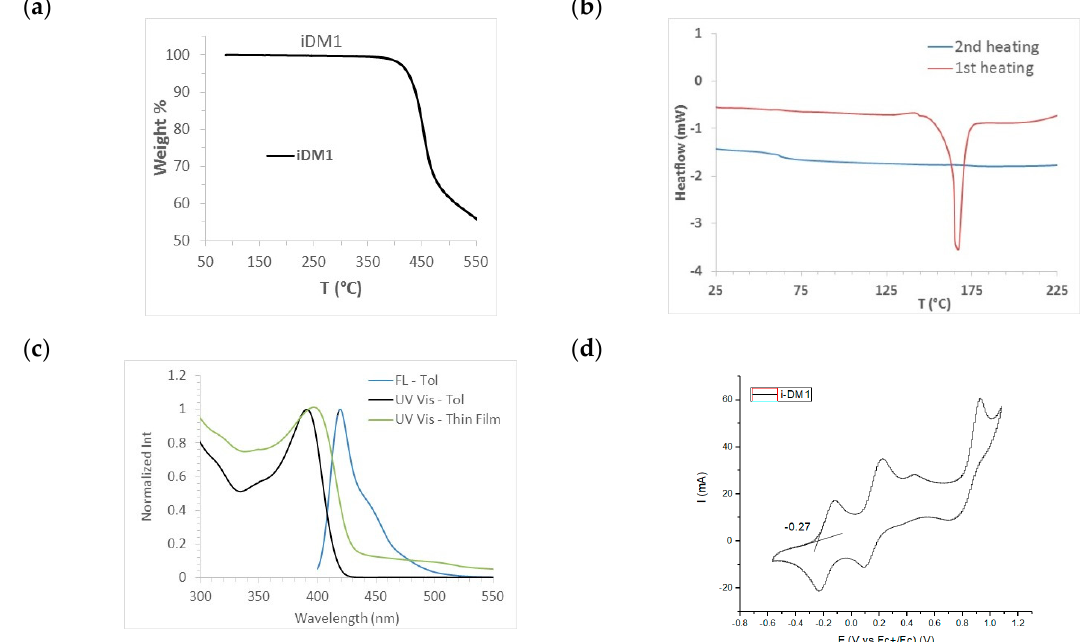
Figure 1. Thermogravimetric analysis (TGA) ( a , b ) di ff erential scanning calorimetry analysis (DSC) curves, ( c ) absorption and photoluminescence spectra and ( d ) cyclic voltammogram of iDM1 .